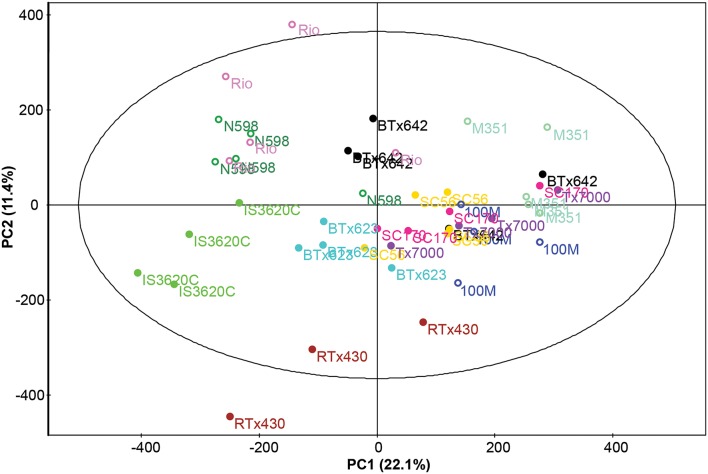
Scores plot from PCA of the metabolomic analysis of 11 sorghum lines. Data from GC- and LC- MS analyses were combined. Biomass types are shown with open symbols and grain types with closed symbols.